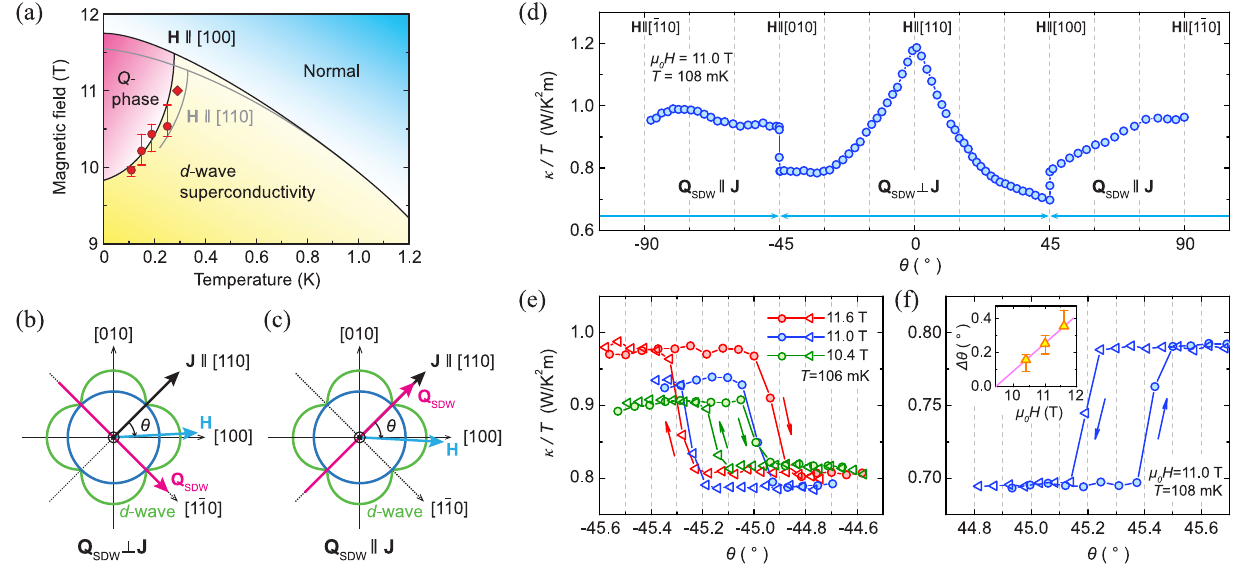
FIG. 1. (a) Phase diagram of CeCoIn 5 , showing the Q phase, based on specific heat measurements [7]. The red data points are obtained from the present measurements, and the details are explained in Fig. 2. (b,c) Schematic diagrams that illustrate switching of the SDW magnetic domain ( Q ) as the magnetic field H is rotated about [100]. The heat current J is in the nodal [110] direction. Q SDW switches to be more perpendicular to H , while lying along the nodes of the d -wave order parameter represented by the green curve. The blue circle represents the normal Fermi surface and the magnetization of the SDW points out of the plane. (d) The thermal conductivity of CeCoIn 5 κ divided by temperature T in the Q phase as a function of the angle θ between H and the heat current J ∥ ½ 110 (cid:2) , at 11 T and 108 mK. The magnetic field is rotated between − 90 ° and þ 90 ° within the crystallographic ab plane. At 45° and − 45 °, the antiferromagnetic ordering vector Q switches between (0.44, 0.44, 0.5) and (0.44, − 0 . 44 , 0.5), as in (b,c) [27]. When Q SDW ⊥ J to Q ∥ J , the thermal conductivity increases by approximately 15%. (e) Hysteretic behavior of the thermal from Q SDW SDW conductivity in the switching region around θ ¼ − 45 °, showing a first-order-like anomaly, for several fields. (f) Hysteretic behavior around θ ¼ 45 °. The inset shows the width of the hysteresis as a function of magnetic field [from